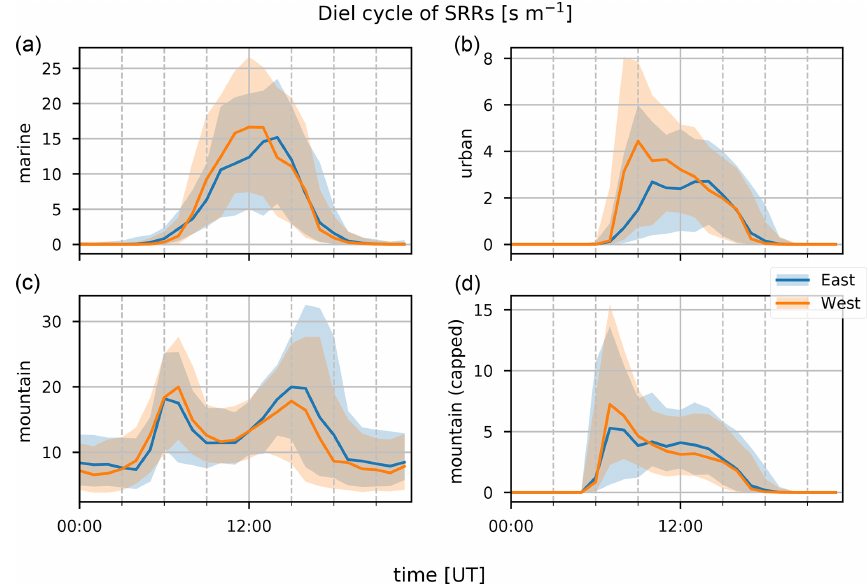
Figure 16. Wind-separated median diel profile (line) and interquartile distance (shaded area) for easterly (blue) and westerly (orange) transport for the marine (a) , urban (b) , mountain (c) , and capped mountain (d) emission source SRRs (sm − 1 ) as calculated using the FLEXPART-AROME 12h back-trajectory calculations. Wind direction separation is based on